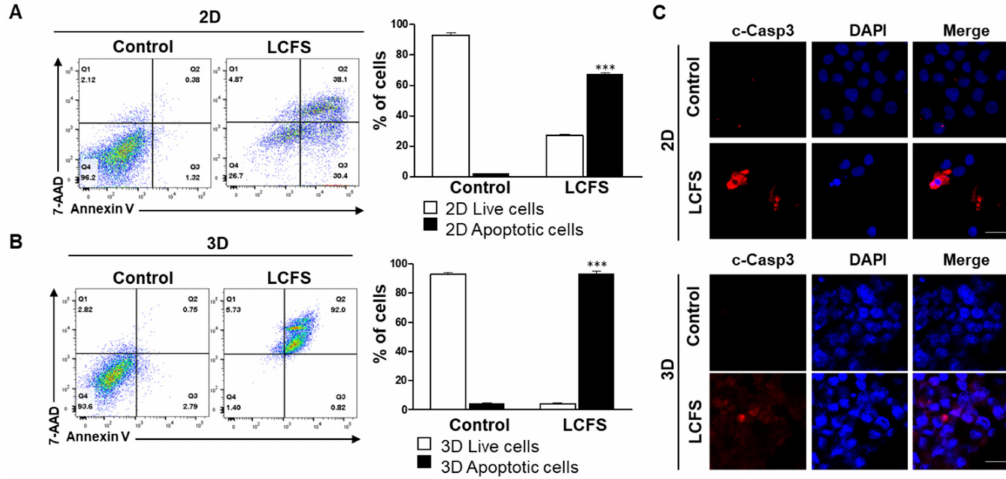
Figure 3. Determination of LCFS-increased apoptosis in 2D and 3D HCT-116 cells. ( A ) Apoptosis determined through flow cytometry. The results show that LCFS could induce apoptosis in 2D and 3D HCT-116 ( n = 3, *** p ≤ 0.001, 100 × magnification, scale bar: 20 µ m). ( B ) Apoptosis analysis was performed in 3D HCT-116 using flow cytometry ( n = 3, *** p ≤ 0.001, 100 × magnification, scale bar: 20 µ m). ( C ) 2D and 3D of LCFS-treated cells were determined using confocal imaging with antibodies specific for cleaved caspase 3